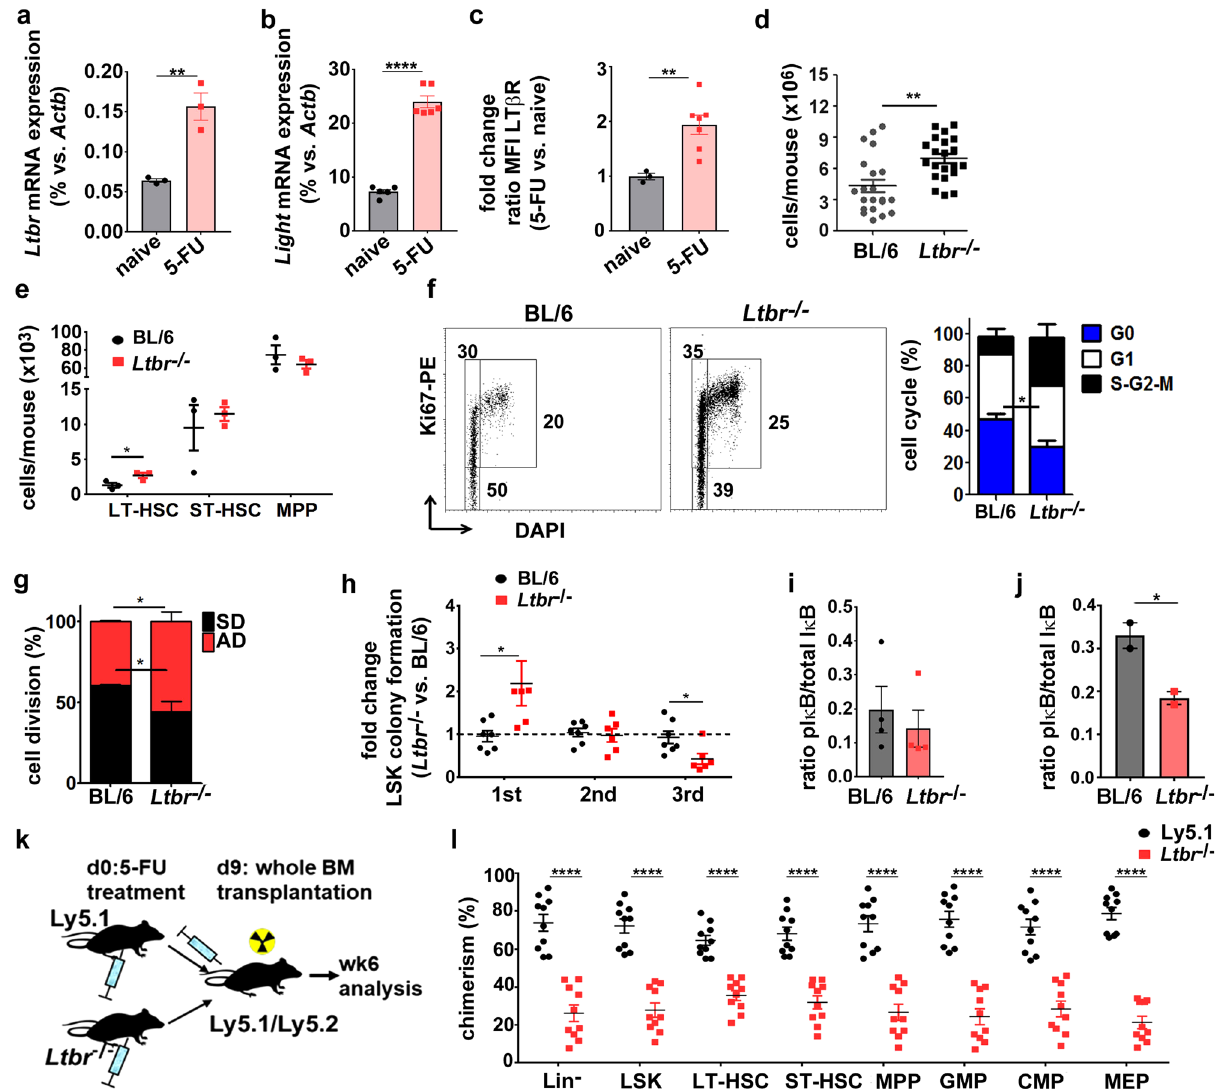
Fig. 5 Treatment of Ltbr − / − mice with 5-FU leads to increased HSC cell cycle activity and reduced long-term repopulation. a , b Quantitative RT-PCR analysis of Ltbr ( a ) and Light ( b ) in BM LSKs from naive (black) and 5-FU-treated (red) BL/6 mice 8 days after treatment (for Ltbr : n = 3, for Light : n = 6). c Fold change of LT β R MFI on HSCs from 5-FU-treated BL/6 (red, n = 7) vs. naive BL/6 mice (black, n = 3). d Total BM cell numbers of BL/6 (gray) and Ltbr − / − mice (black) 8 days post 5-FU injection (BL/6 n = 20, Ltbr − / − n = 21). e Total numbers of BM LSK subpopulations in 5-FU-treated BL/6 (black) and Ltbr − / − mice (red), n = 3. f Left: representative FACS pro fi les of cell cycle analysis of BM LSKs. Right: Percentage of BL/6 and Ltbr − / − LSKs in each cell cycle phase, blue: G0, white: G1, black: S – G2 – M. Data represent one out of two independent experiments; LSKs were pooled for analysis from BL/6 n = 3 and Ltbr − / − n = 5 mice. g Percentages of FACS-puri fi ed LSKs from 5-FU-treated BL/6 and Ltbr − / − mice in symmetric (SD, black) or asymmetric division (AD, red). Data represent one out of two independent experiments, LSK numbers n = 73 (BL/6) and n = 85 ( Ltbr − / − ). h Fold change of CFU capacity of FACS-puri fi ed BL/6 (black) and Ltbr − / − (red) LSKs in serial re-plating experiments, pooled data from two independent experiments are shown (BL/6 n = 5, Ltbr − / − n = 7). i Ratio of I κ B α protein expression and its phosphorylation level of BM LT/ST-HSCs from naive BL/6 (black) and Ltbr − / − mice (red). Data were pooled from two independent experiments (BL/6 n = 5 mice, Ltbr − / − n = 4 mice). j Ratio of I κ B α protein expression and its phosphorylation level of BM LT/ST-HSCs (Lin − sca − 1 + CD48 − CD150 + ) from BL/6 and Ltbr − / − mice 8 days post treatment with 5-FU, n = 2 mice were pooled for each data point. One out of two independent experiments is shown. k Experimental setup of BM reconstitution after 5-FU treatment. l Percentages of Ly5.1 (black) and Ltbr − / − BM donor cells (red) of recipients 6 weeks post transplantation, one out of two independent experiments ( n = 10). Unless otherwise stated, data are presented as mean ± SEM, * P < 0.05, ** P < 0.01, **** P < 0.0001 (two-tailed t test). a : p = 0.0058; b : p < 0.0001; c : p = 0.0092; d : 0.0039; e : p = 0.030; f : 0.025; g : p = 0.042; h : 1st p = 0.031, 3rd p = 0.025; i : p = 0.55; j : p = 0.047; l : p <